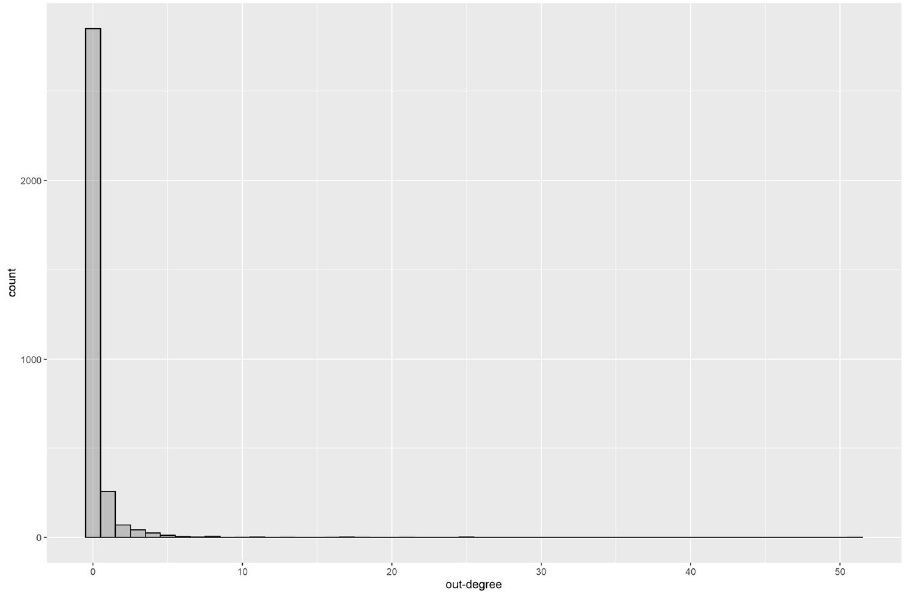
Figure 2. A histogram of